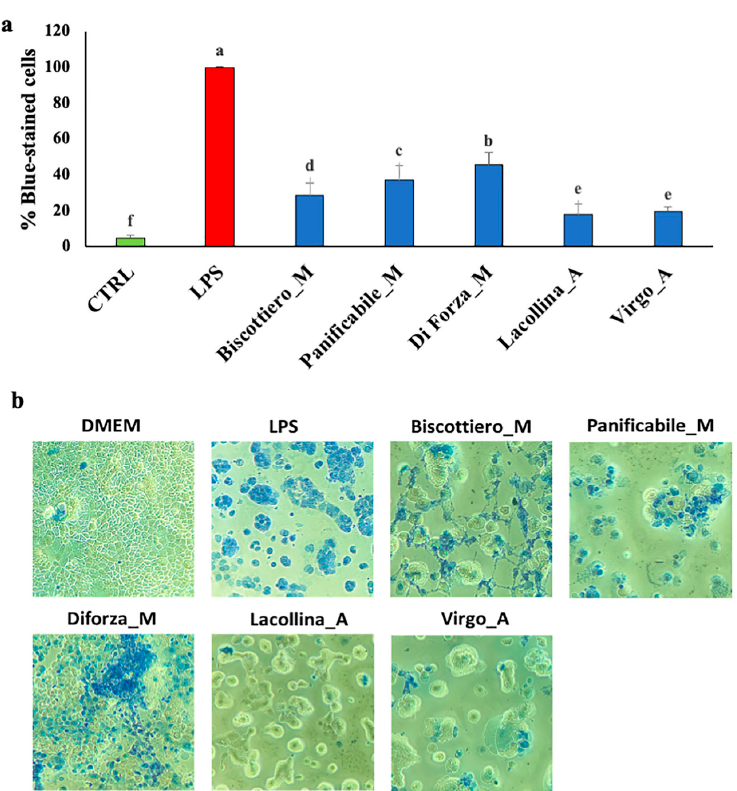
Figure 4. Cell vitality of Caco-2 cells in co-culture ( a ) showing the percentage of trypan blue-stained cells and ( b) phase contrast microscopy (40× magnification) images of the Caco-2 cells after a 24 h exposure either 1 µg/mL LPS or 40 µg/mL total protein (albumins + globulins + glaidins + glutenins) from three commercially available modern wheat mixes (denoted by M) and two heritage wheat mixes (denoted by A). The designation of the letters a, b, c, and d represents significant differences between varieties as determined by one-way ANOVA at the 95% confidence level ( p ≤ 0.05).